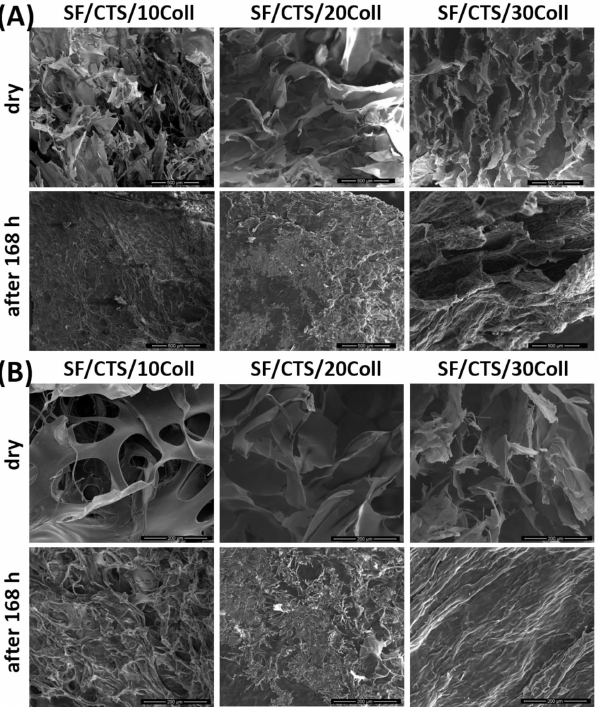
Figure 10. SEM images of SF/CTS mixtures with 10, 20 and 30% of Coll, cross-linked by EDC/NHS, for dry scaffolds and scaffolds after 168 h of immersion in PBS: ( A ) magnification 500 × ; ( B ) magnifi- cation 150 ×